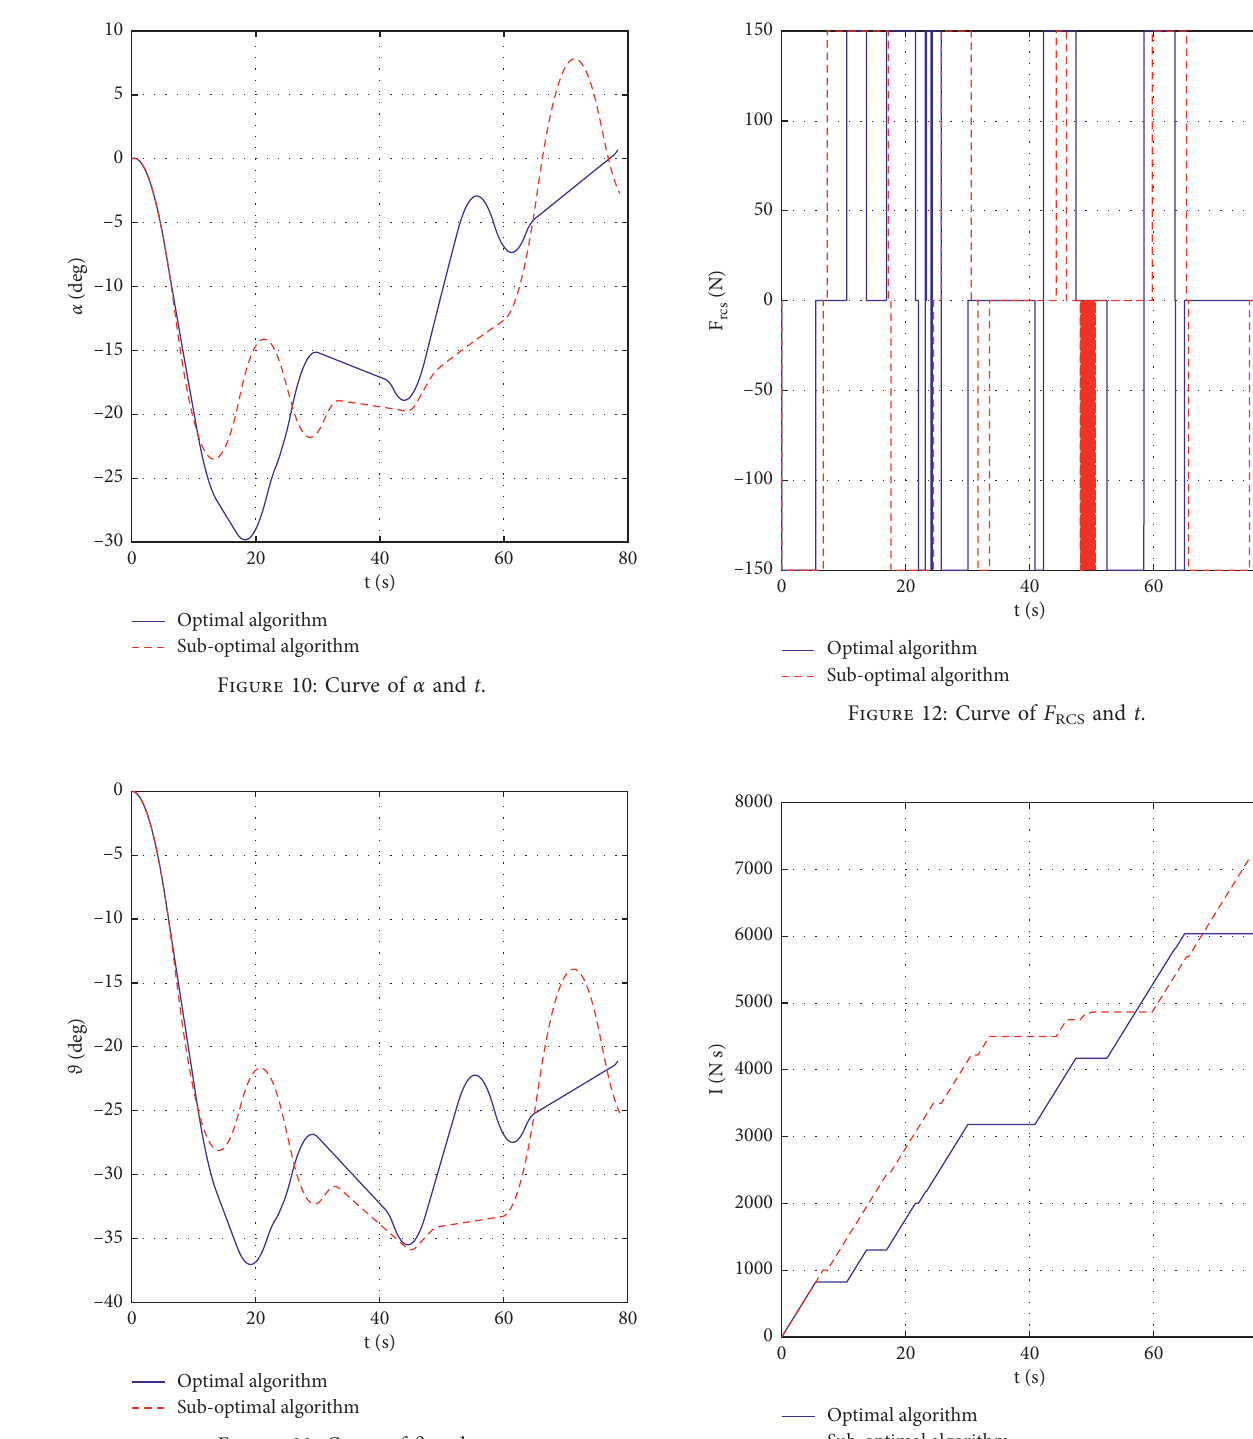
Figure 11: Curve of ϑ and t .